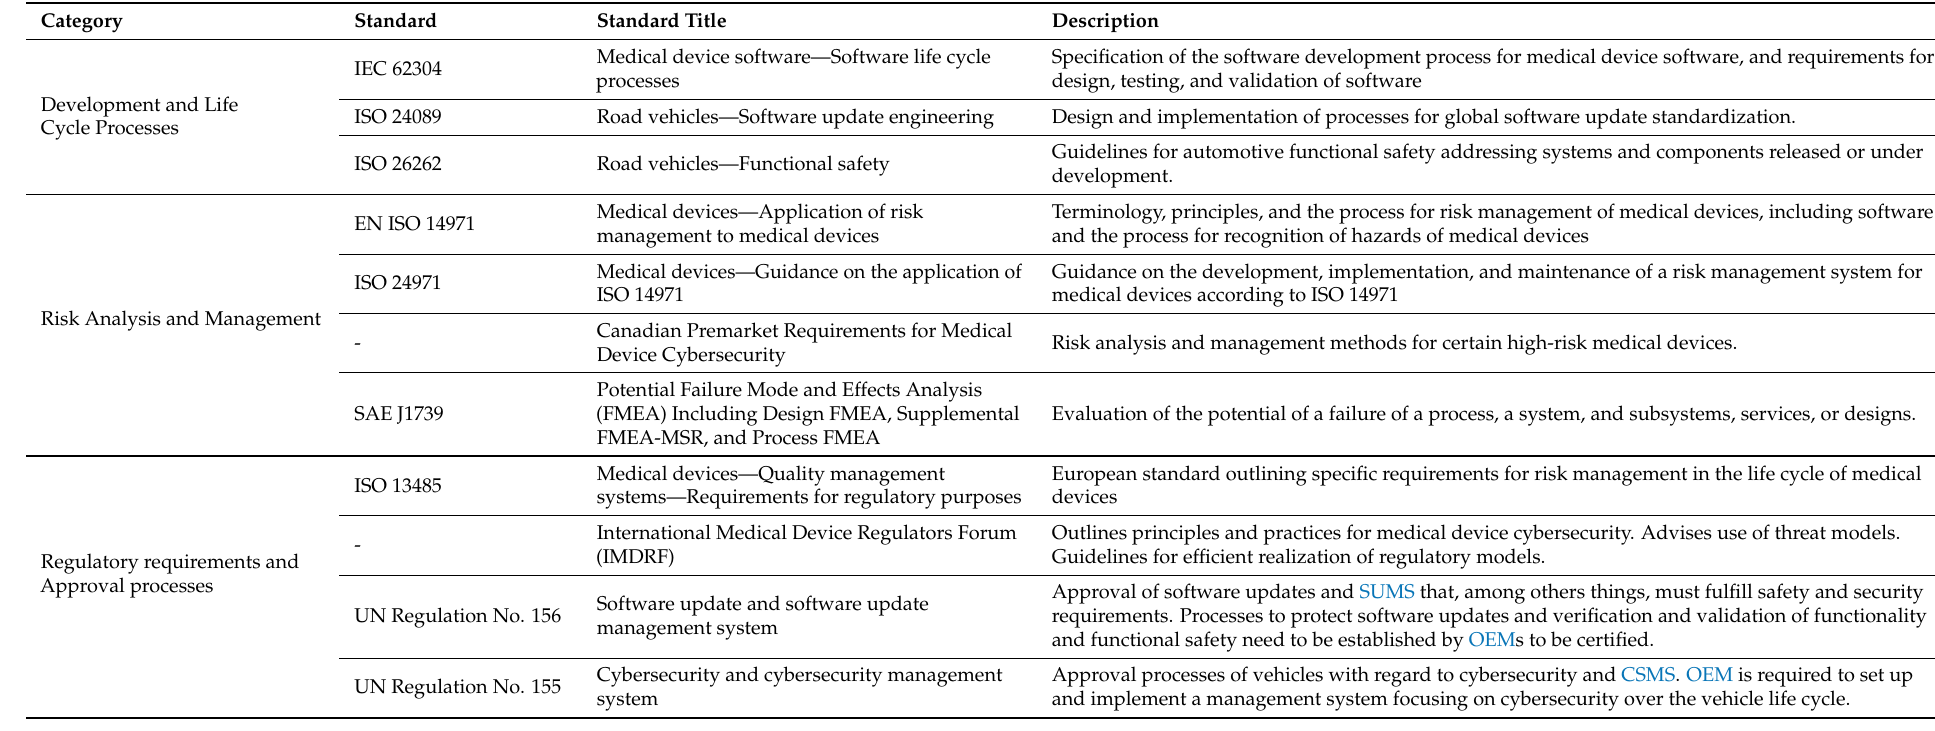
Table 2. Medical device and automotive standards and guidelines addressing safety and